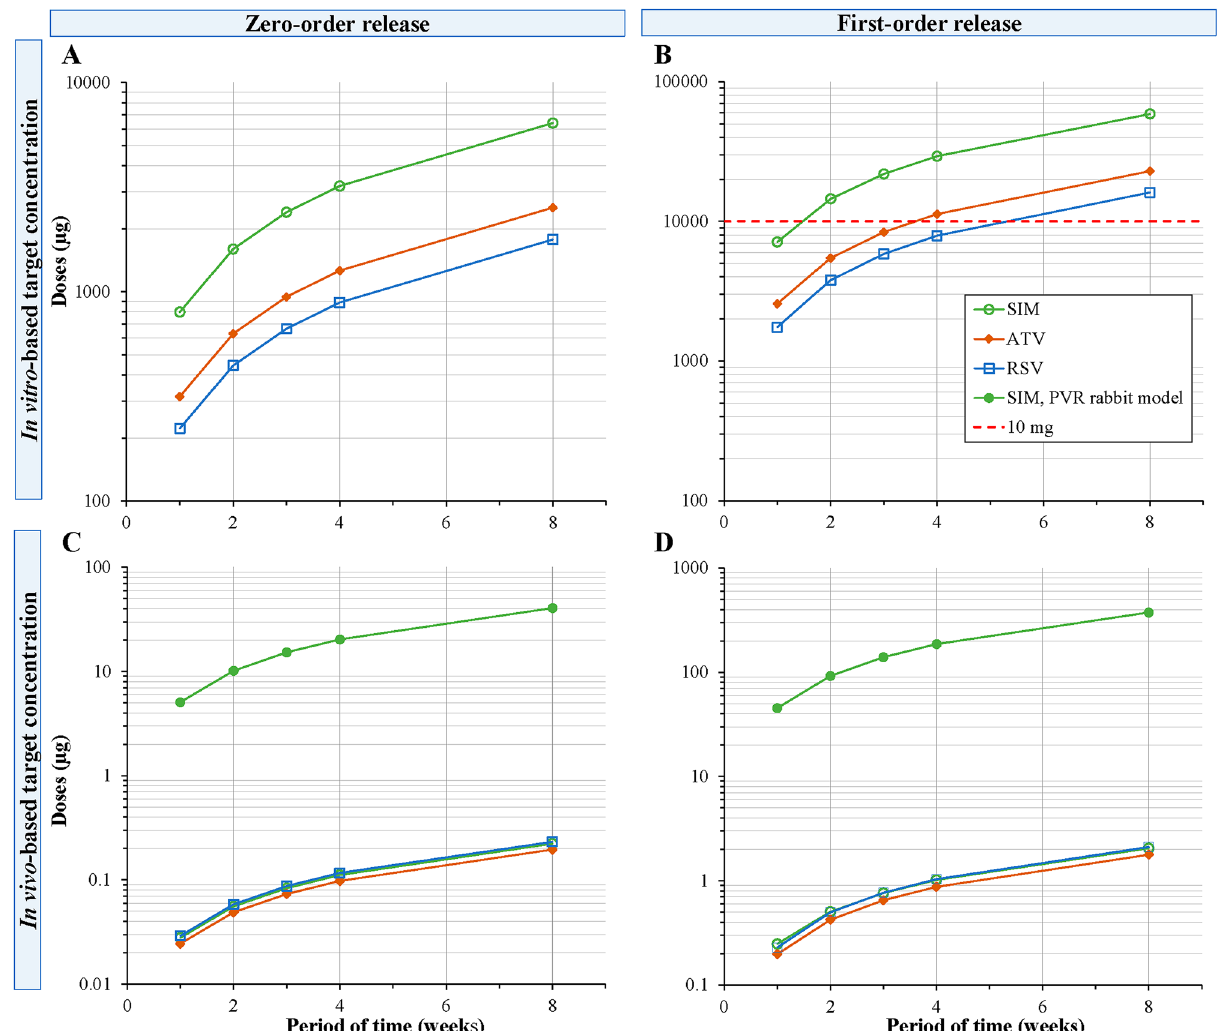
Figure 6. Plots presenting the doses of simvastatin (SIM), atorvastatin (ATV), and rosuvastatin (RSV) required to load in drug delivery systems to achieve target concentration based on the in vitro ( A , B ) or in vivo concentrations ( C , D ) presented in Table 3 for time treatment between one week to 2 months depending on the risk level of harmful secondary fibrosis in RRD patients. The red dashed line represents the maximum loading for 100 µl intravitreal delivery system, the filled green circles represents the doses required based on simvastatin effective concentration in PVR rabbit model ( 16 , calculation shown in “Materials and Methods”).